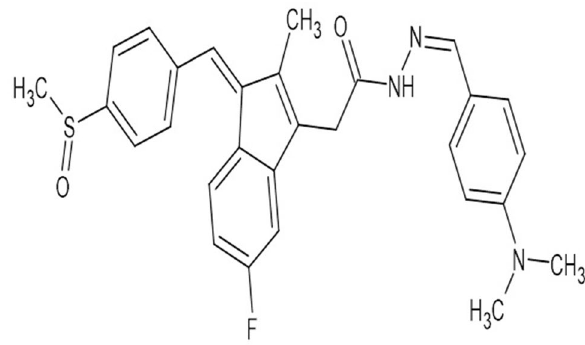
Figure 1. Structure of a Novel Sulindac derivative